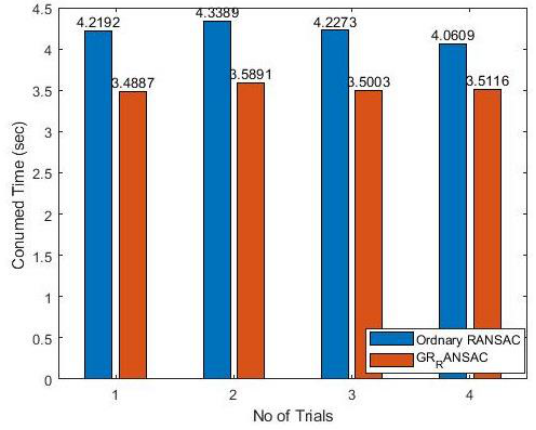
Figure 9. Comparison of execution time obtained from the GR_RANSAC and ordinary